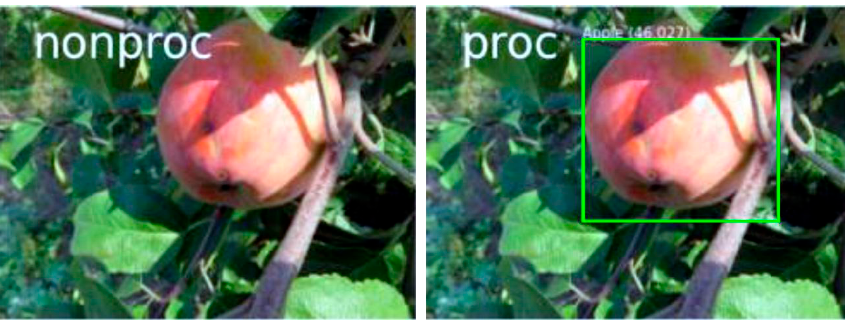
Figure 13. Apple detection used in estimation of crop growth and yield [49].